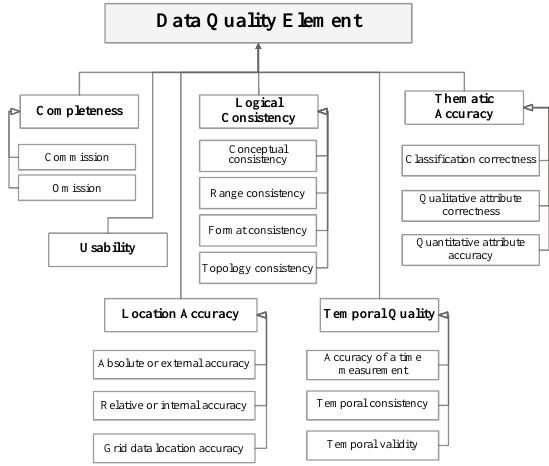
Figure 3 . Quality description framework of natural resources satellite remote sensing data and common